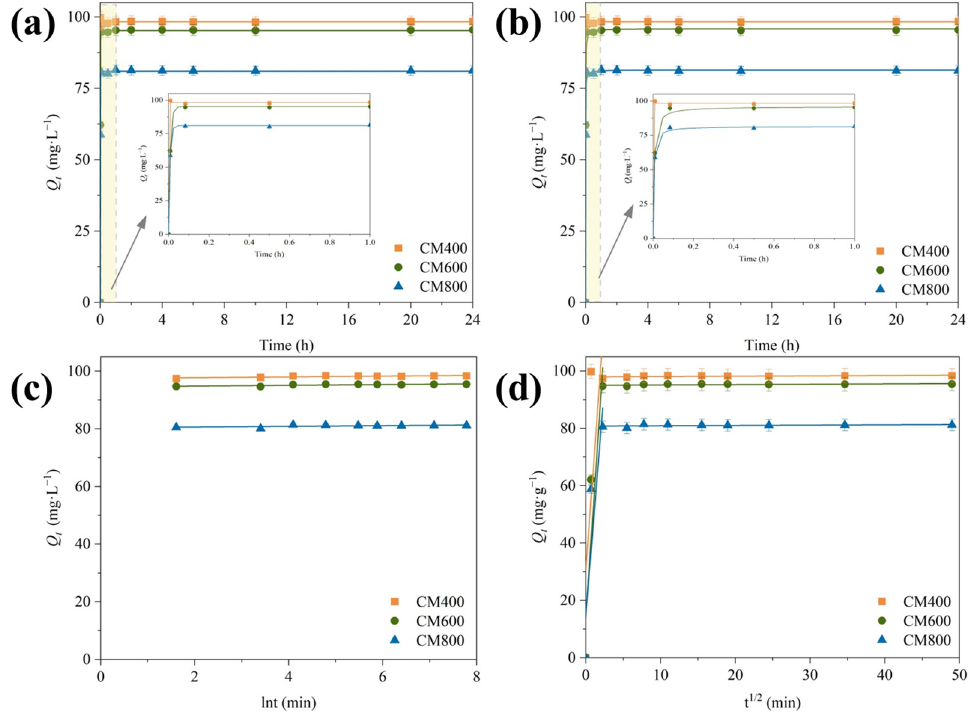
Figure 4. Adsorption kinetics of Pb(II) by CMBC. ( a ) Pseudo-first-order model, ( b ) pseudo-second-order model, ( c ) Elovich model, and ( d ) internal diffusion model. Experimental conditions: [initial concentration of Pb(II)] = 100 mg·L − 1 , [dosage] = 1 g·L − 1 , [temperature] = 25 °C.